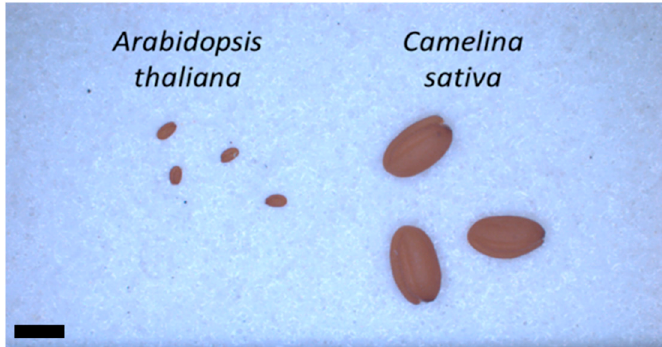
Figure 8. A. thaliana and C. sativa seeds. The scale bar is 1 mm.